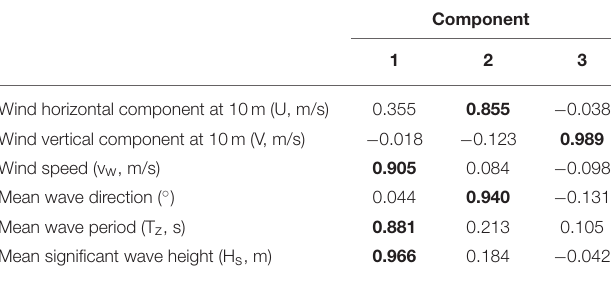
TABLE 3 | Factor loadings of the PCA solutions. Higher correlations are highlighted in